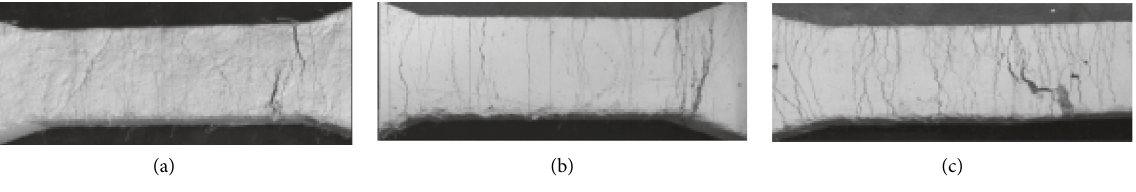
Figure 5: Failure phenomenon of PE-ECC with the water-binder ratio of 0.27 and different KF contents: (a) 7 days, (b) 28 days, (c) 60 days.